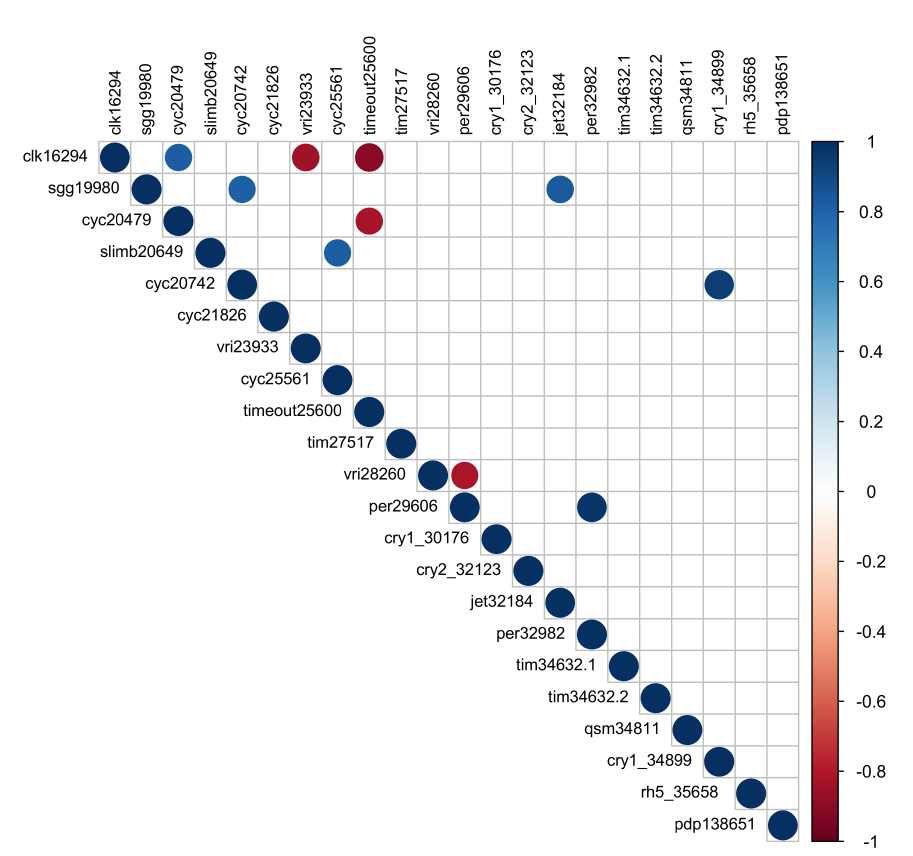
Figure 6. Pairwise correlations among 22 transcripts for circadian genes. Only significant ( p < 0.05) correlations shown. Blue indicates positive correlations, red indicates negative. Transcripts listed by gene symbol and comp